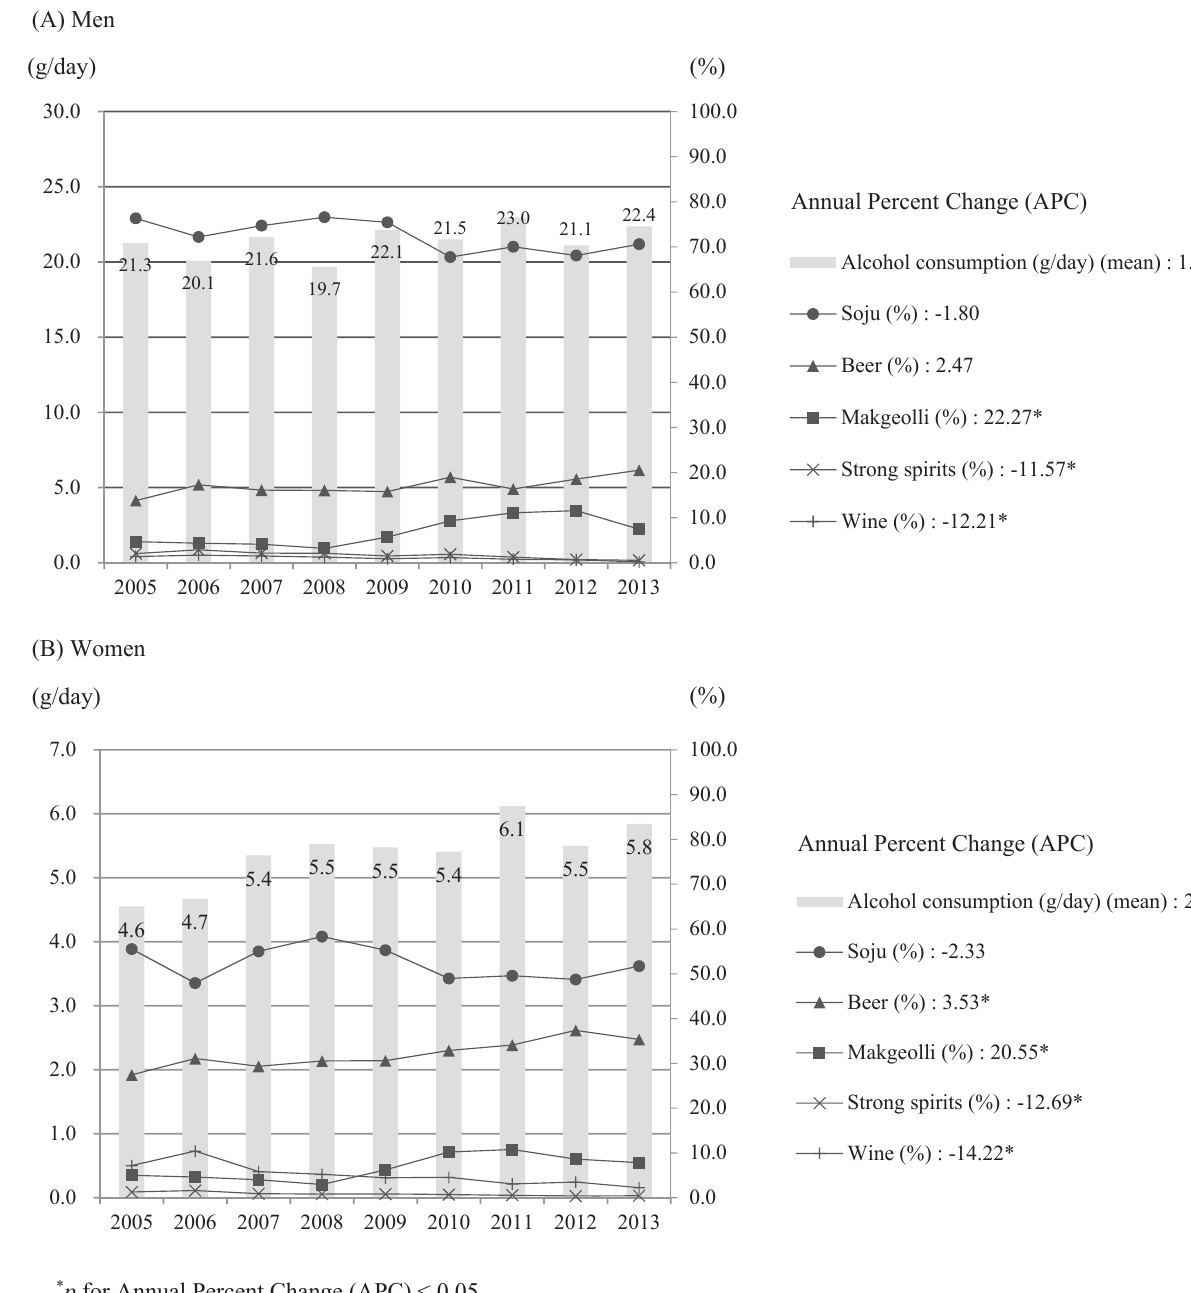
Figure 2. Trends in age-standardized mean of total alcohol consumption and percentage of alcohol brought by types of